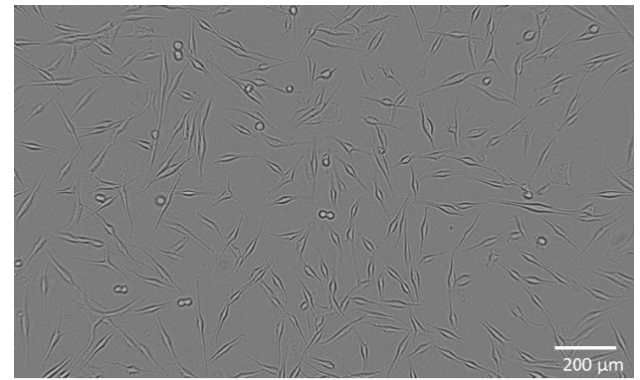
Figure 6. Melanoma cells WM-266-4 during cultivation.